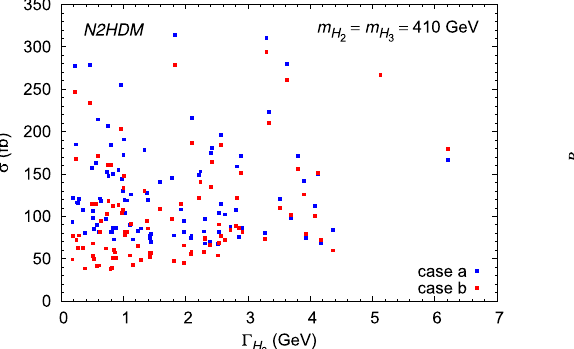
Fig. 5 Left – Cross sections for the points obtained from the N2HDM parameter space scan with m H the cases a (blue) and b (red) as functions of (cid:12) H